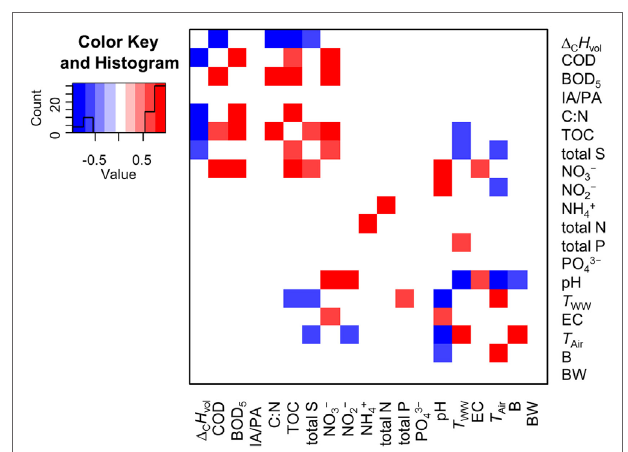
FigUre 1 | Heat map of a correlation analysis with all determined wastewater parameters. Red, positive correlation coefficient; blue, negative correlation coefficient ( − 1 ≤ x ≤ + 1); white, no correlation. All possible correlations were tested according to Pearson, Spearman, and Kendall. Afterwards the p -value was corrected via the Benjamini–Hochberg algorithm. If two correlation tests were significant ( p < 0.05), the respective correlation was included to the heat map. The depicted correlation coefficients are the calculated means. Δ C H vol , heat of combustion (kJ L − 1 ); COD, chemical oxygen demand (g L − 1 ); BOD 5 , biochemical oxygen demand after 5 days of incubation (mg L − 1 ); IA/PA, ratio of the intermediate alkalinity over the partial alkalinity; C:N, ratio of organic carbon and inorganic nitrogen; TOC, total organic carbon (mg L − 1 ); total S, total sulfur content (mg L − 1 ); NO 3 − ,